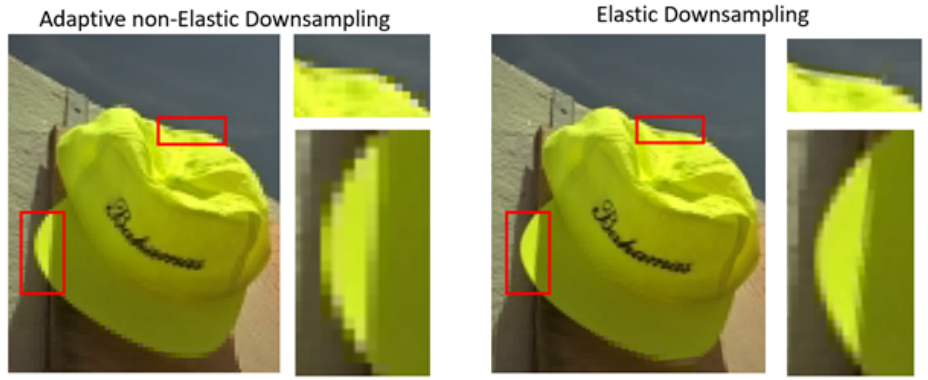
Figure 15. Detail of artifacts at adaptive nonelastic vs. elastic downsampling at 7% of image samples.